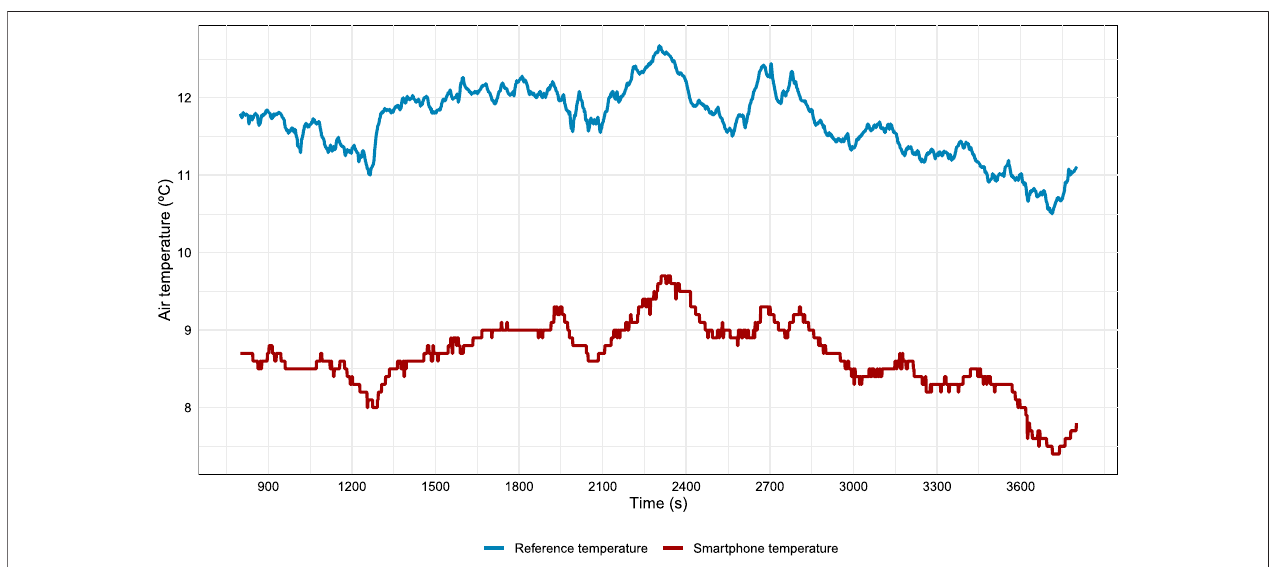
FIGURE 11 | Smartphone measurements uncorrected for temperature bias and reference tricycle measurements. Measurements took place across a prede fi ned path on October 17 th 2017, in the evening, to ensure low radiation bias. The time axis represents the start since the experiment: the cut-off part was setting up the measurement devices.